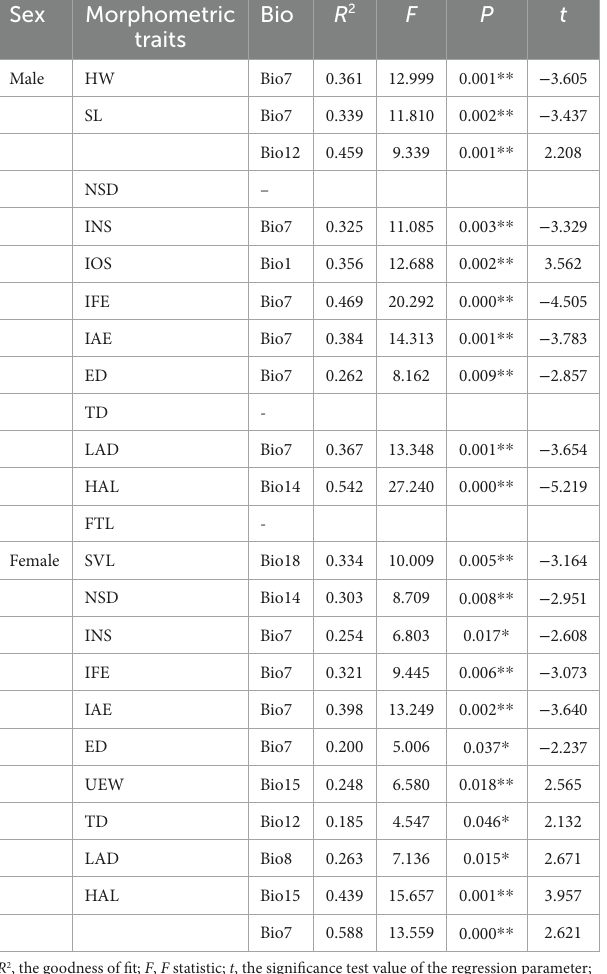
TABLE 5 Stepwise regression analysis results for morphometric traits against nine bioclimatic factors of Odorrana graminea sensu stricto. Sex Morphometric